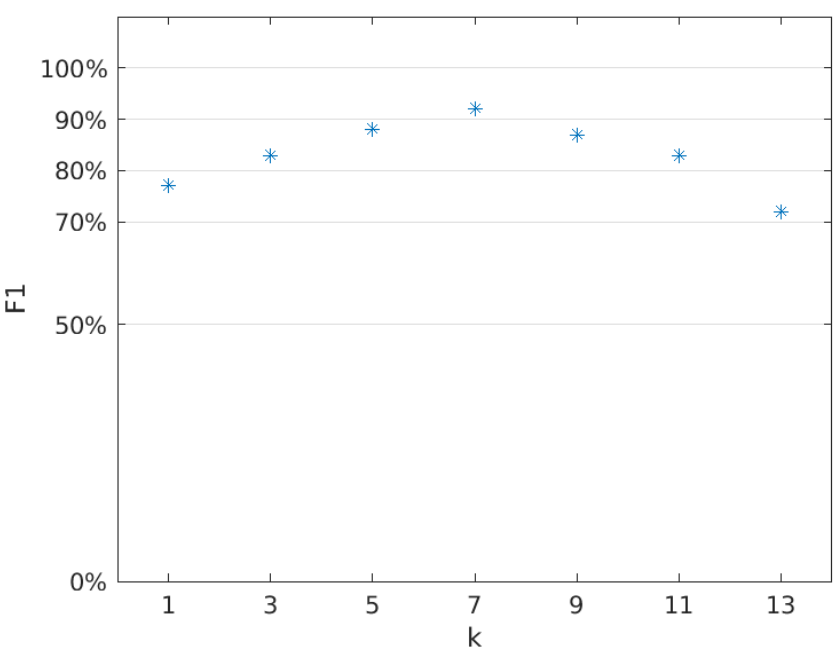
Figure 12. The value of the F1 metric depending on the parameter k .